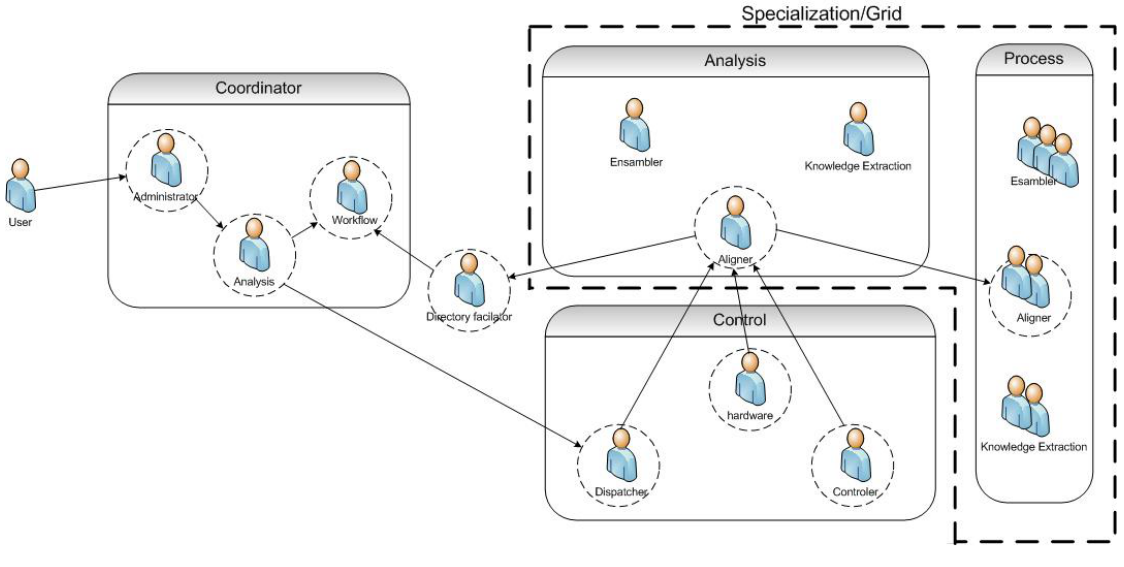
Figure 2: Basic functionality of the